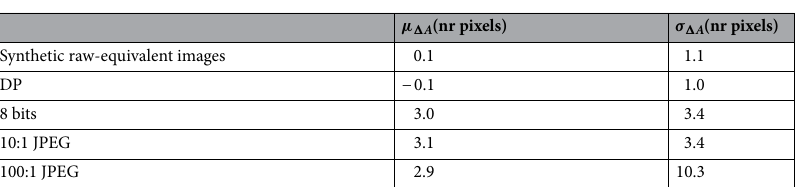
Table 1. Parameters of the distribution of the difference in the single-object area (∆A) obtained from the synthetic and compressed PC microspheres’ image with respect to the raw format (Fig. 2c).